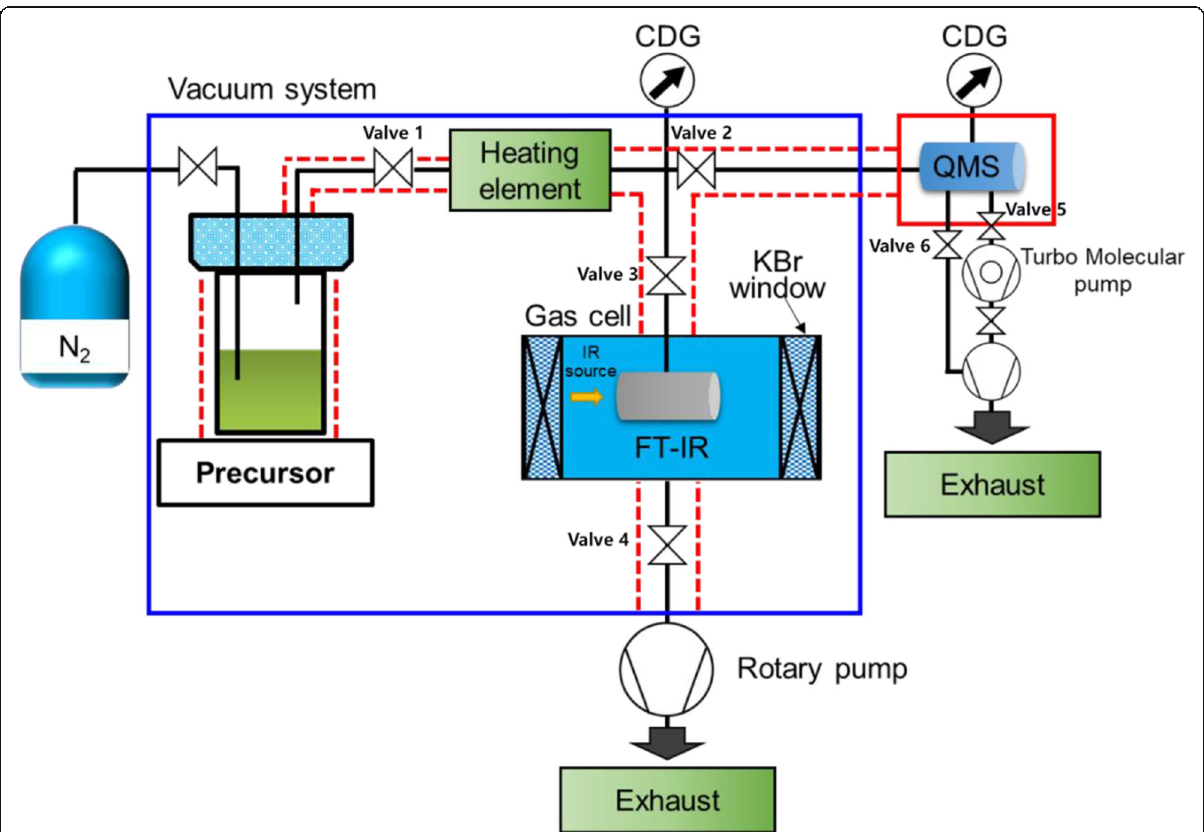
Fig. 1 Schematic of the newly designed in-situ monitoring